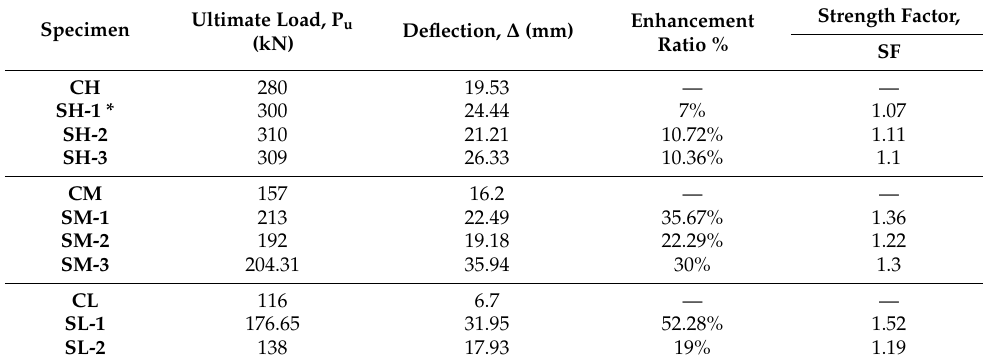
Table 5. Test results of all tested beams.